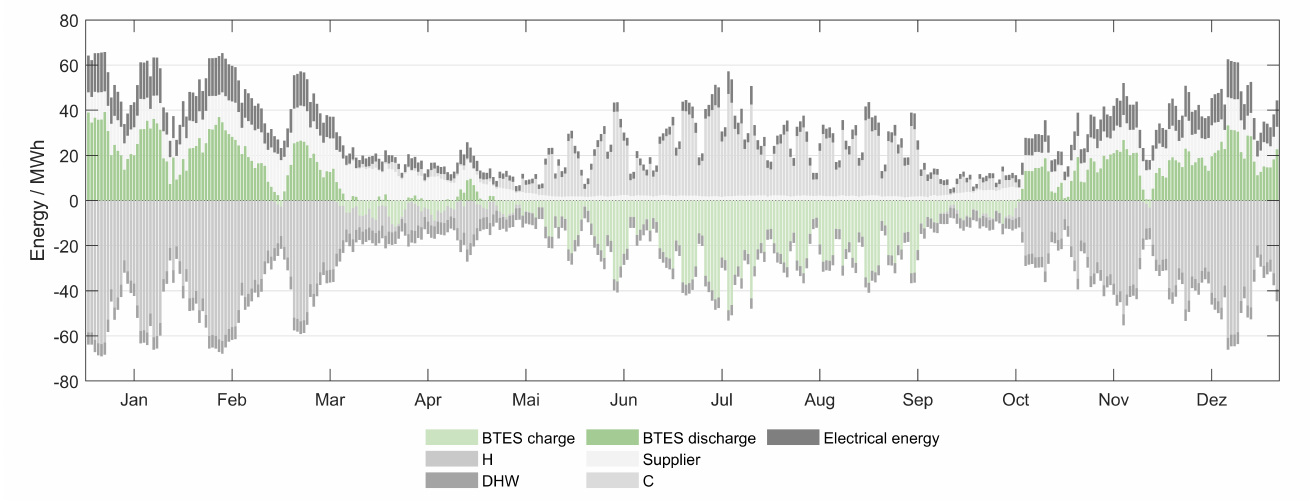
Figure 17. Annual energy flows in daily resolution to operate the ULTDH grid.